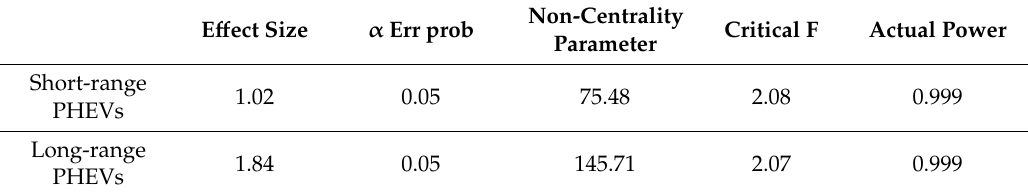
Table A2. Post-hoc Test: Compute achieved power for a given α , sample size, and e ff ect